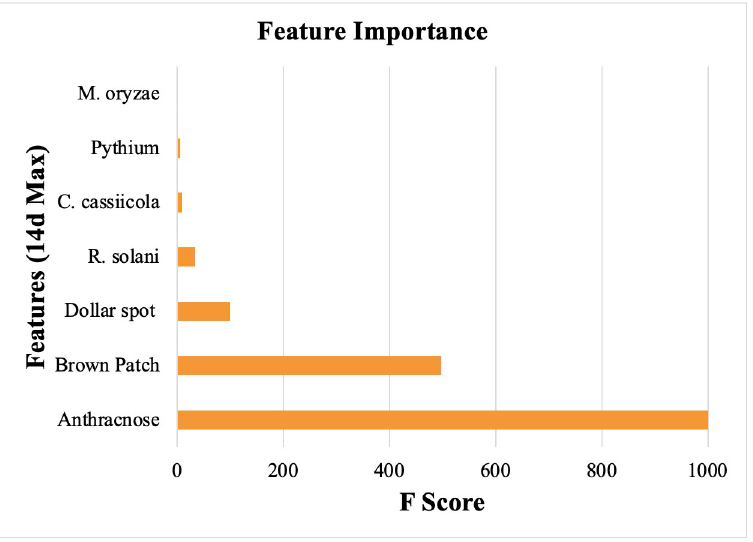
Fig 9. F-score analysis conducted in Python of climatic data related to death events of Poa annua plants monitored for length of life from May to October 2021 in a zoysiagrass ( Zoysia matrella Merr., cv. Trinity) fairway. Plants were either left without treatment or treated with fungicide mixtures intended to control dollar spot ( Clarireedia spp.), anthracnose ( Colletotrichum cereale ), Pythium blight ( Pythium spp.), and brown patch ( Rhizoctonia solani ) every 14